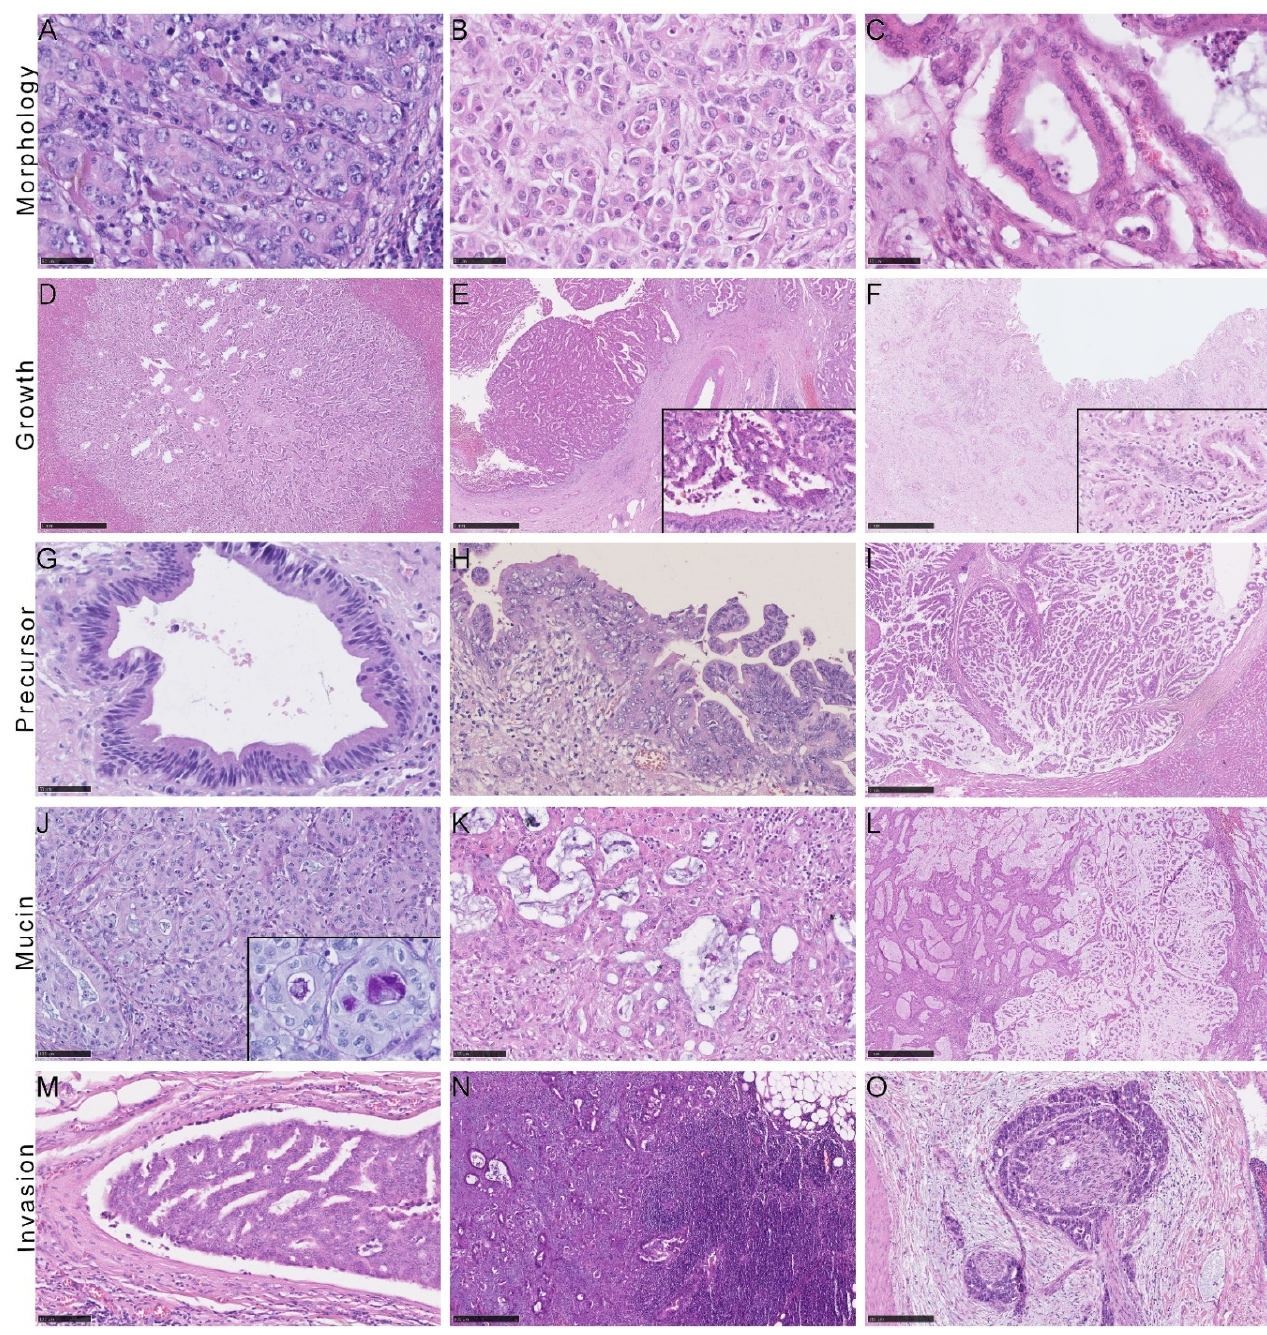
Figure 2. Histological distinction features of iCCA. ( A ) Adenocarcinoma forming solid sheets; ( B ) with cuboidal cells; ( C ) Infiltrative glands composed of prismatic cells. Different histological growth patterns of iCCA showing ( D ) a mass-forming (MF) tumor, ( E ) a tumor showing intraductal growth (IG), and ( F ) a tumor with periductal-infiltrating growth. Note the adjacent inconspicuous biliary epithelium (inlay; ( E , F )). ( G ) Biliary intraepithelial neoplasia of low-grade and ( H ), 200X magnification) high-grade; ( I ) intraductal papillary neoplasm of the bile ducts. Different amounts of mucin: ( J ) little mucin with PAS-positivity showing in the inlaid picture; ( K ) moderate and ( L ) extensive amounts of mucin. ( M ) Lymphangioinvasion and ( N ) lymph node metastasis. ( O ) Perineural invasion.